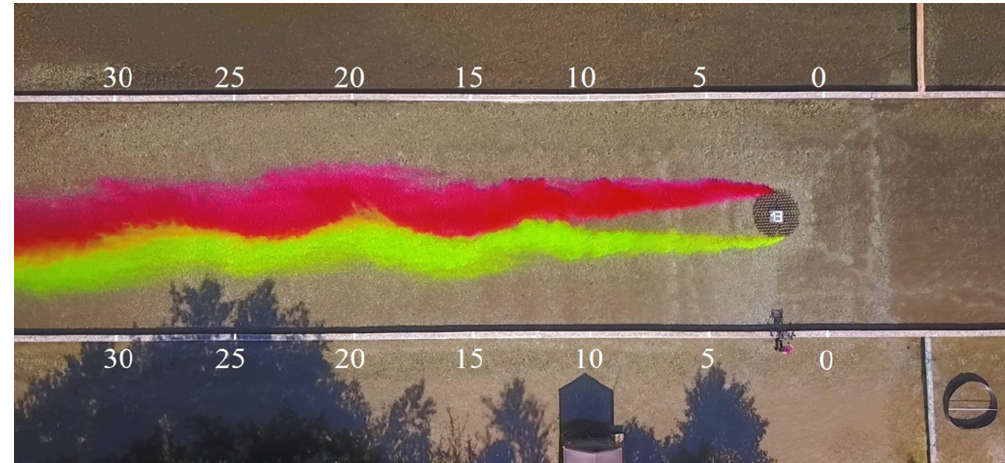
Figure 8. Example of JPEG image recorded in run 13 (numbers on the picture mark the distances in metres for the bench marks on the walls).